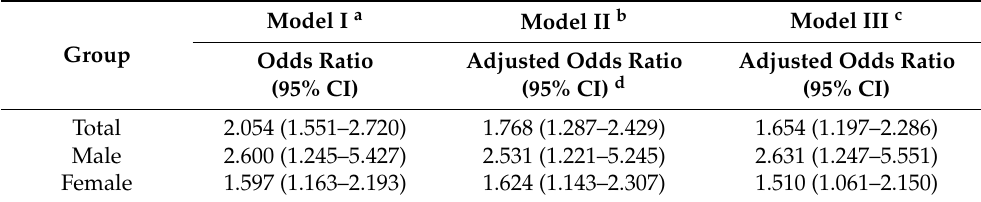
Table 3. Odds Ratios (ORs) of major depressive disorder (MDD) by